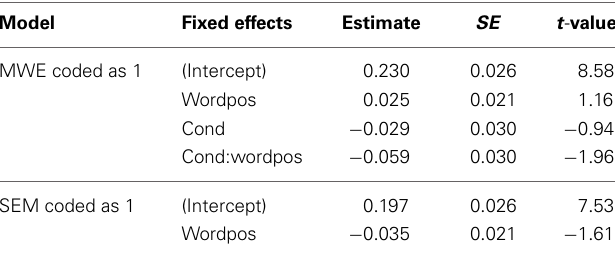
Table 4 | Fixed effects for Theta/Alpha